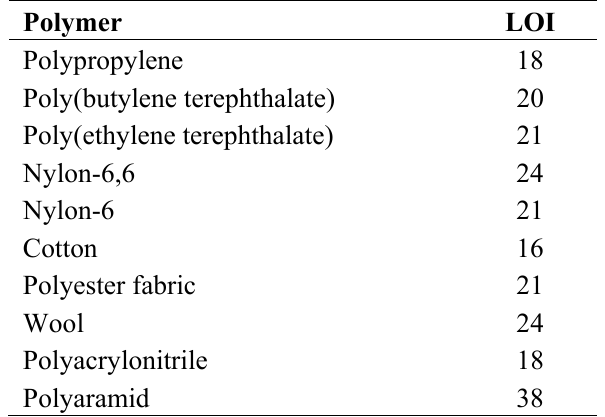
Table 1. Limiting oxygen indices of some polymers.